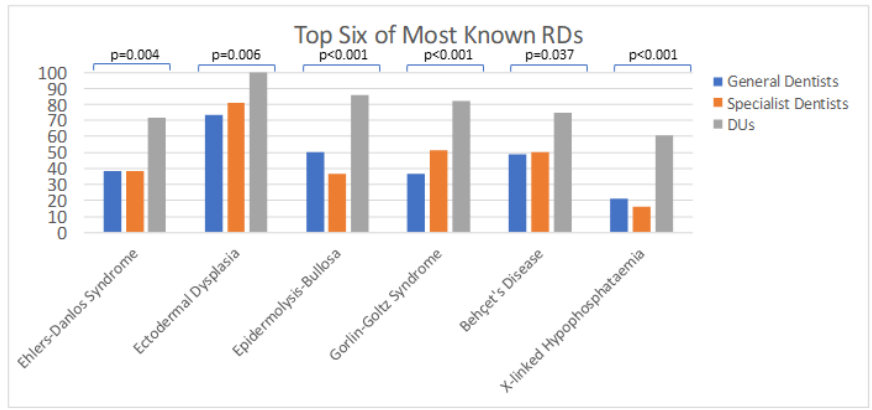
Figure 1. Data in %. Differences between the groups of dentists were tested via two-sided chi-square-test. Rare disease (RD).